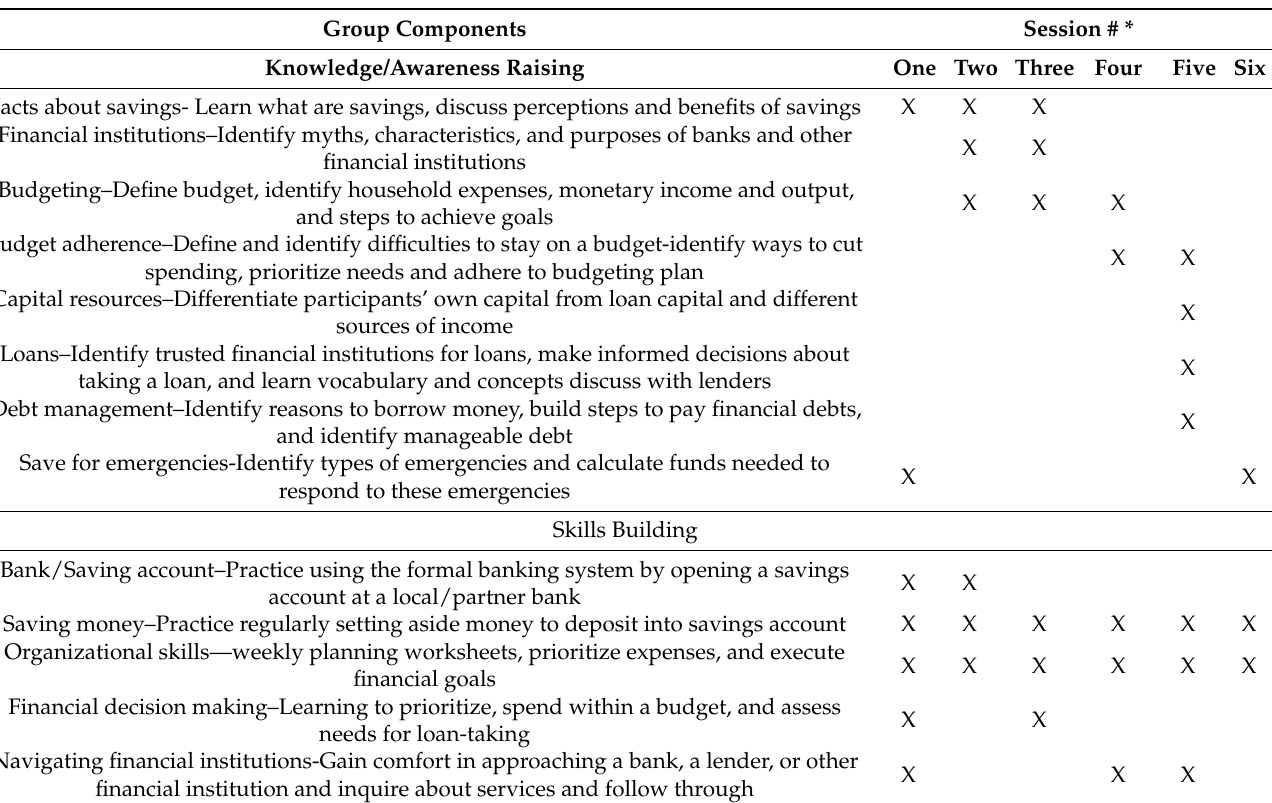
Table 3. Group components integrated into financial training